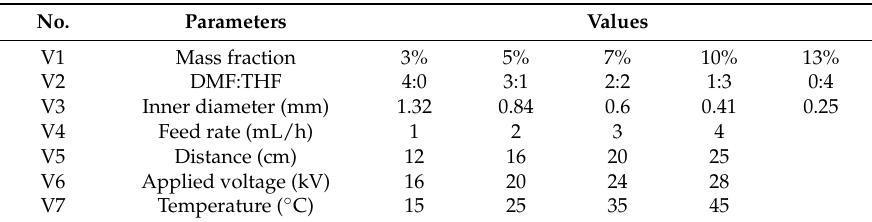
Table 1. The specific values of different